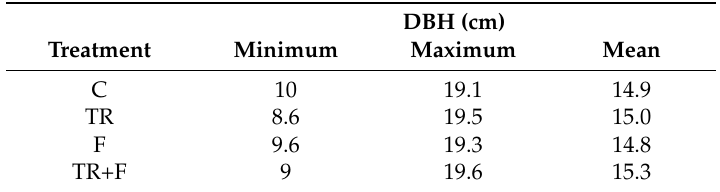
Table 1. Minimum, maximum, and mean DBH of sap flow measurement trees during the winter of 2012–2013 for the control (C), throughfall reduction (TR), fertilizer application (F), and throughfall reduction and fertilizer application (TR+F)